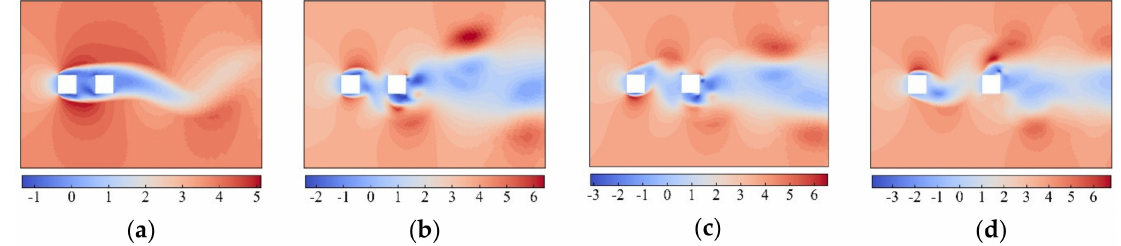
Figure 3. Distribution of transverse velocity U at di ff erent spacing ratios (m / s): ( a ) L / D = 2; ( b ) L / D = 2.5; ( c ) L / D = 3; ( d ) L / D =